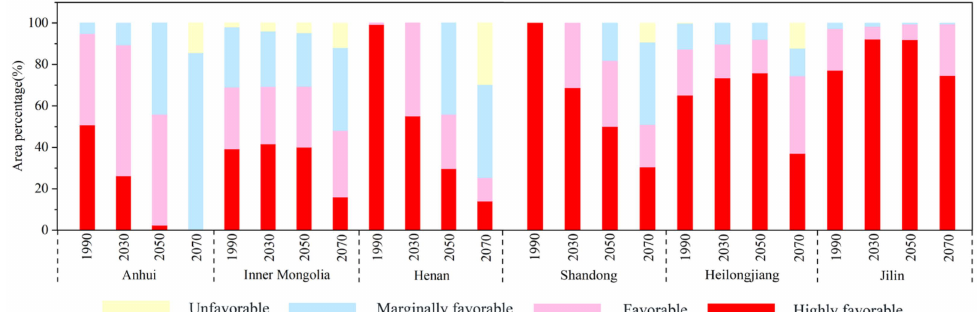
Figure 3. Area percentage changes in different ranges for the suitable distribution for P. interpunctella under current and future climate conditions in six major agricultural provinces of China.